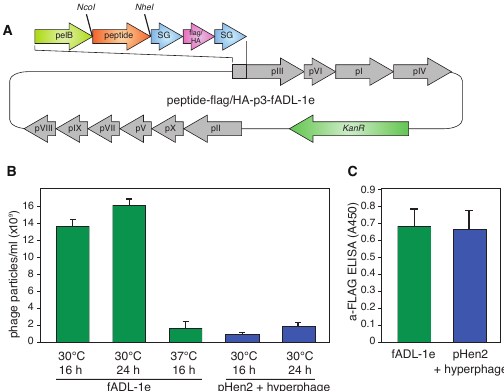
Figure 1. ( A ) Vector map of the fADL-1e-based plasmid for the bacterial expression of the fd filamentous bacteriophage with the p3 protein N-terminally fused with peptide ligand and 3xFLAG or HA-tags flanked by the SG-linkers. The full vector sequences are available online (Addgene ID: 139441 (3xFLAG) and Addgene ID: 139440 (HA)); ( B ) Yield of the bacteriophage expression by the fADL-1e- and pHen2-transformed cells after 16 or 24 h of incubation at 30 or 37 ◦ C; ( C ) Level of the 3xFLAG-p3 in the bacteriophages (10 9 particles / mL) produced by the fADL-1e- or pHen2-hyperphage-based systems measured by